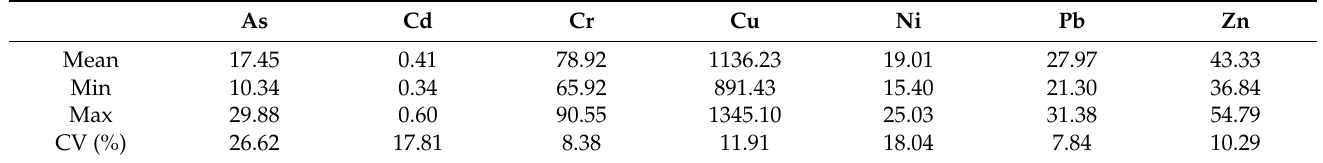
Table 1. Heavy-metal contents in mine tailings